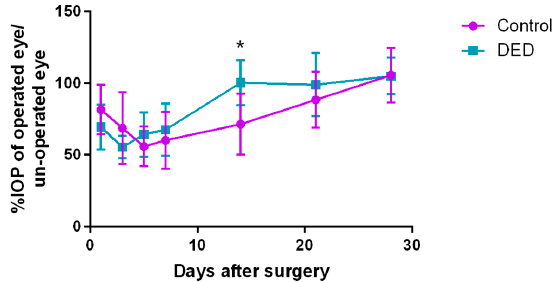
Figure 5. Postoperative intraocular pressure (IOP)% changes over 28 days in the two groups. The IOP% decreased markedly on day 5 in the control group and on day 3 in the DED group. Then, it gradually increased with time in both groups. On day 14 after surgery, the IOP% in the DED group was significantly higher than that in the control group. The differences in the IOP% between the two groups were not significant on days 1, 3, 5, 7, 21 and 28 after surgery. * p < 0.05.